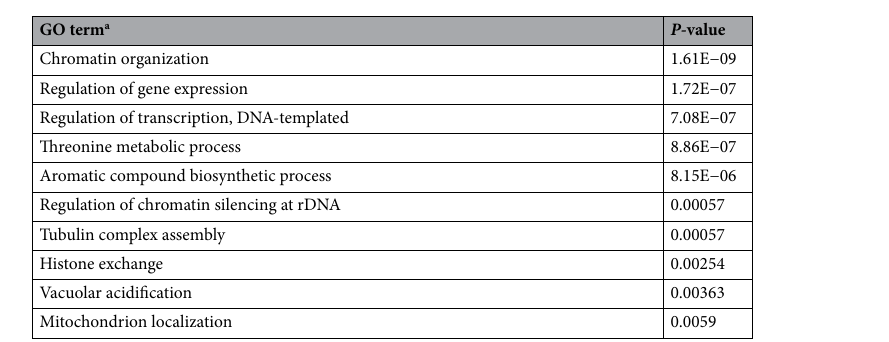
Table 1. Biological processes associated with genes causing Ni(S-tcitr) 2 sensitivity when deleted. a Biological process Gene Ontology (GO) terms were identified and evaluated for statistical significance ( P -value < 0.01) with the GO TermFinder program (https ://www.yeast genom e.org/cgi-bin/GO/goTer mFind